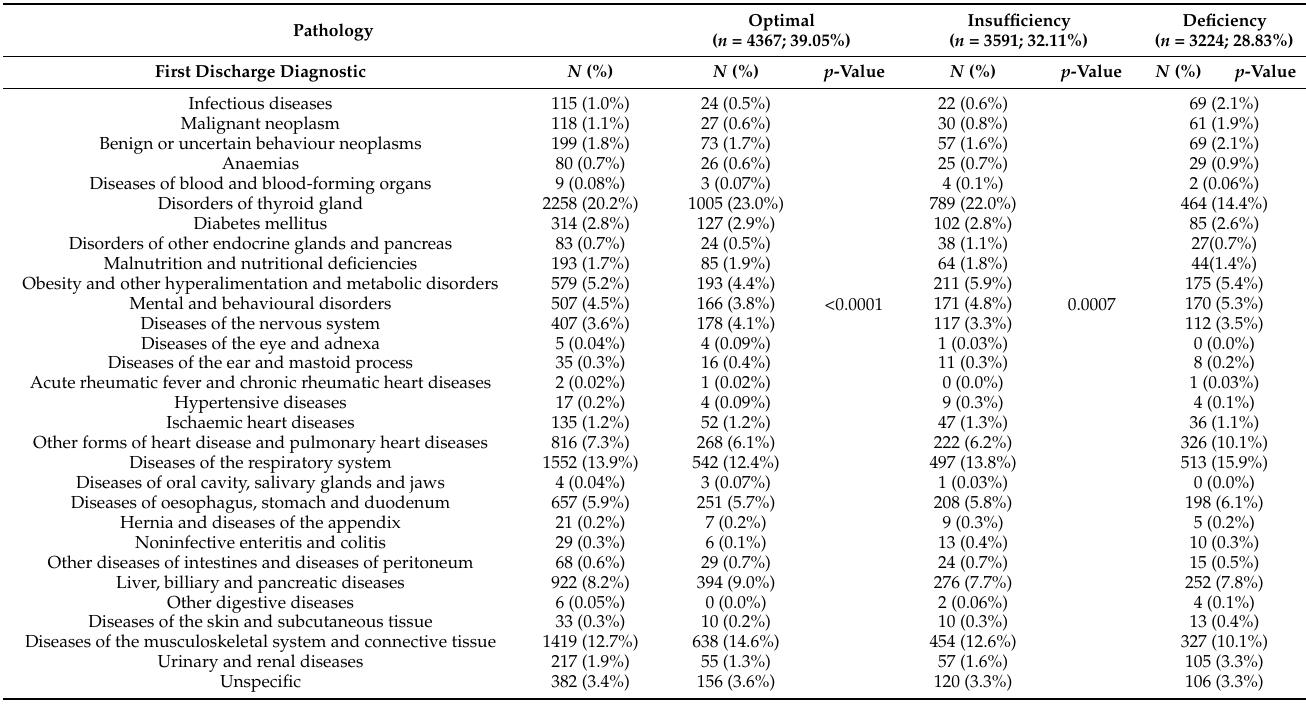
Table 3. Prevalence of vitamin D status and